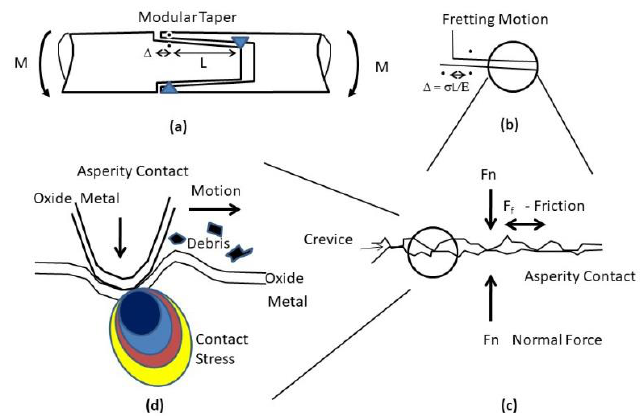
Figure 29. Schematics of the mechanics of fretting [40]. ( a ) Elastic bending strains under an applied bending moment, M , in conjunction with rigidly bound contact point (triangles) can give rise to elastically-based displacements, ∆ , in the taper. ( b ) Zoom-in of elastic fretting strains with the displacement being dependent on the bending stress, elastic modulus and distance from the rigid contact. ( c ) Schematic of a zoom-in onto the contact region within a modular taper. Crevice solution can creep to the contacts and the interface will consist of asperity-asperity contact and both normal and frictional stresses. ( d ) Close-up of metal-oxide surfaces in asperity contact, causing contact stresses, local surface deformation and oxide debris generation [40]. Reprinted with permission from Springer Nature.